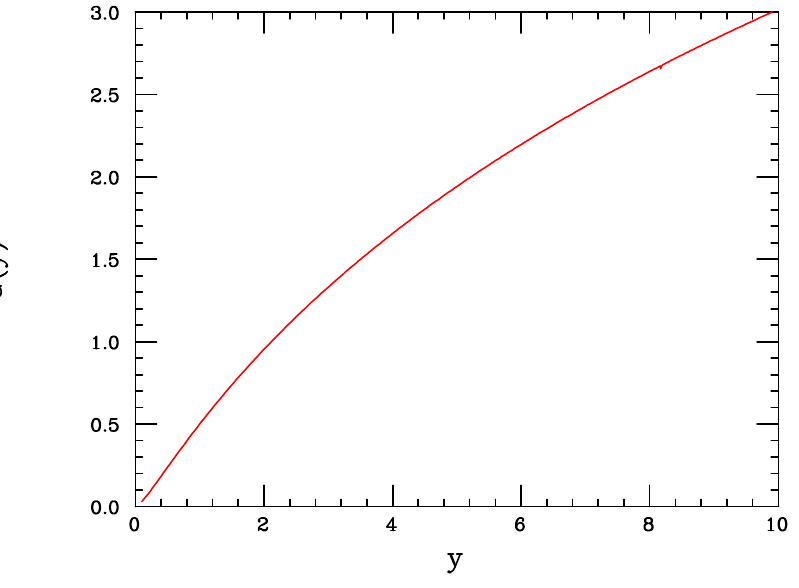
Figure 2 . The function G ( y ) as defined in the text for values of y of